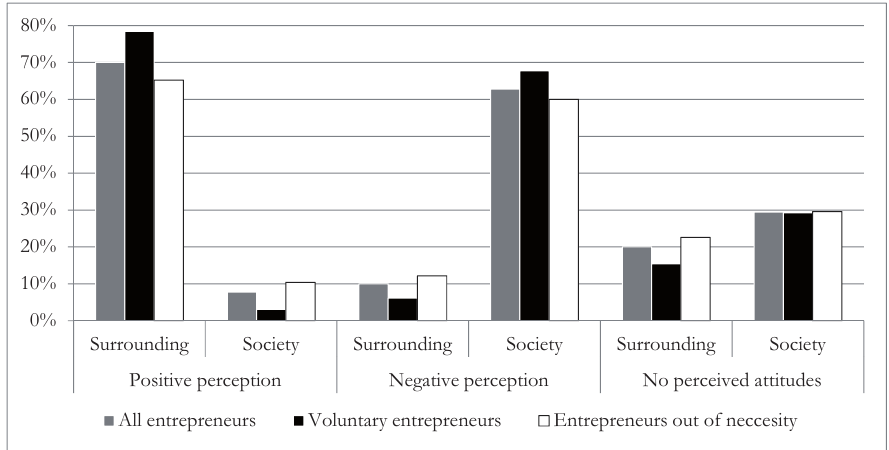
Fig. 1- Attitudes the entrepreneurs perceived in their surroundings and in the society. Source: Authors.